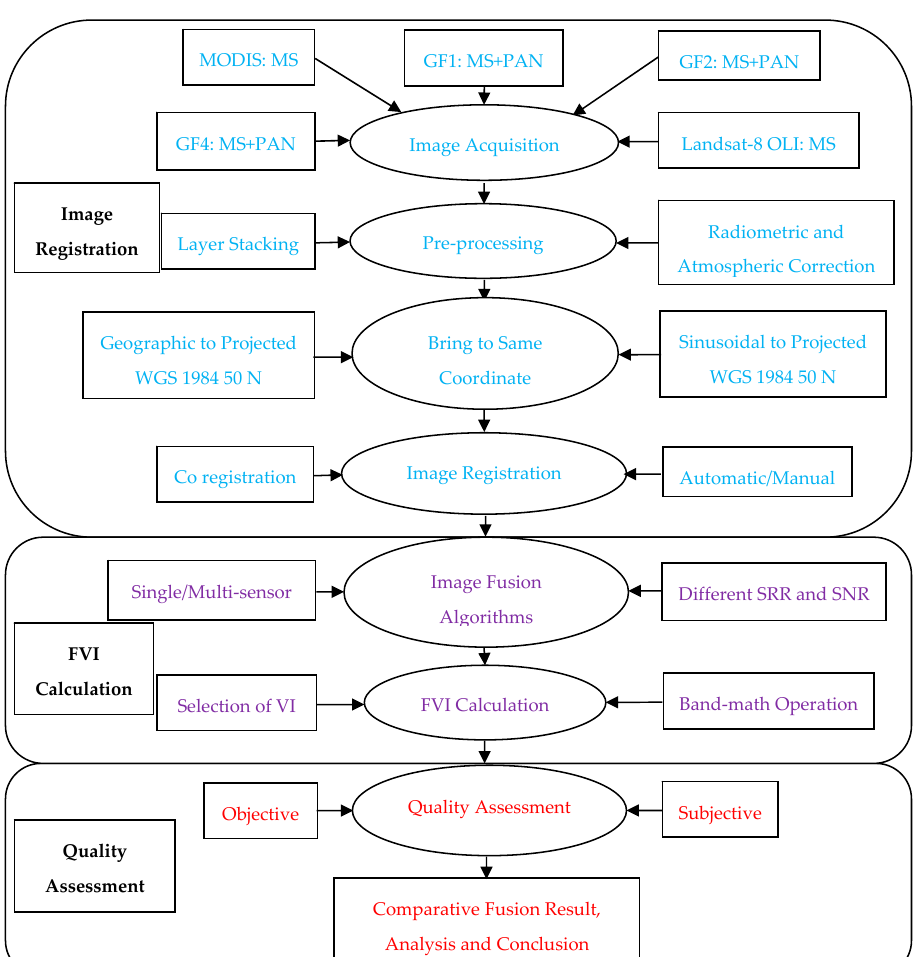
Figure 2. Methodological flow chart of research.